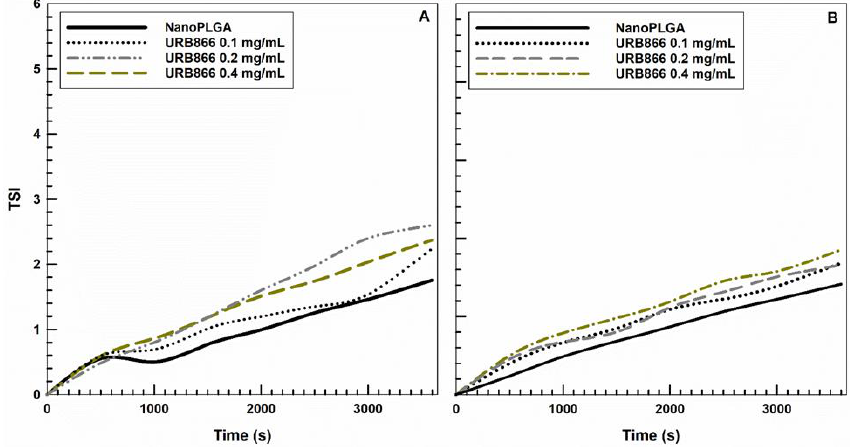
Figure 4 . Turbiscan Stability Index (TSI) profile of PLGA nanoparticles containing various amounts of URB866: ( A ) 25 °C; ( B ) 37 °C.